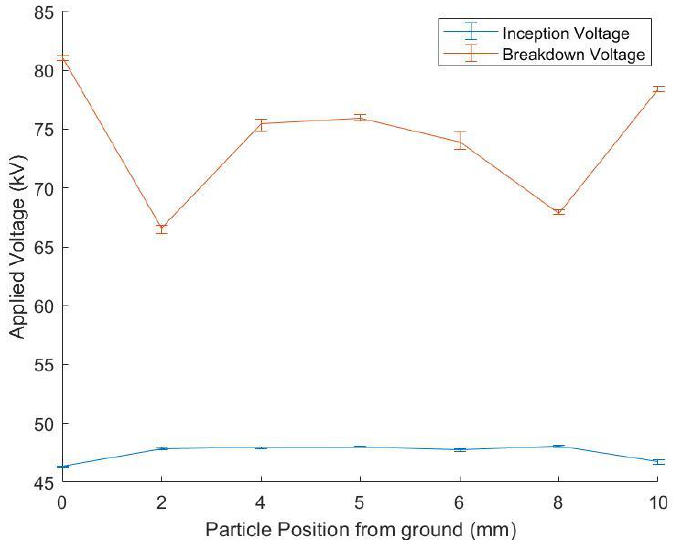
Figure 6. Characteristics of corona inception and breakdown voltages of 8 mm symmetrical particle.